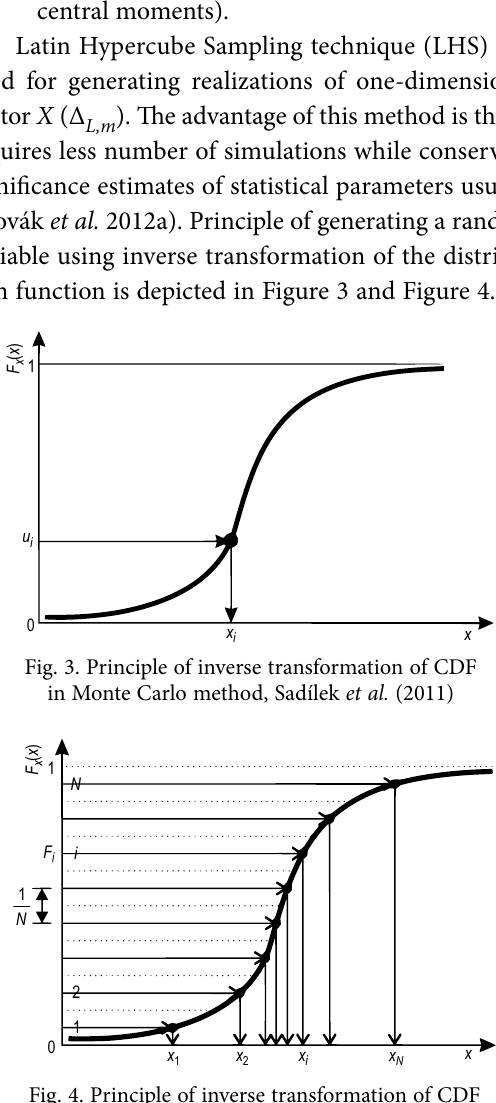
Fig. 4. Principle of inverse transformation of